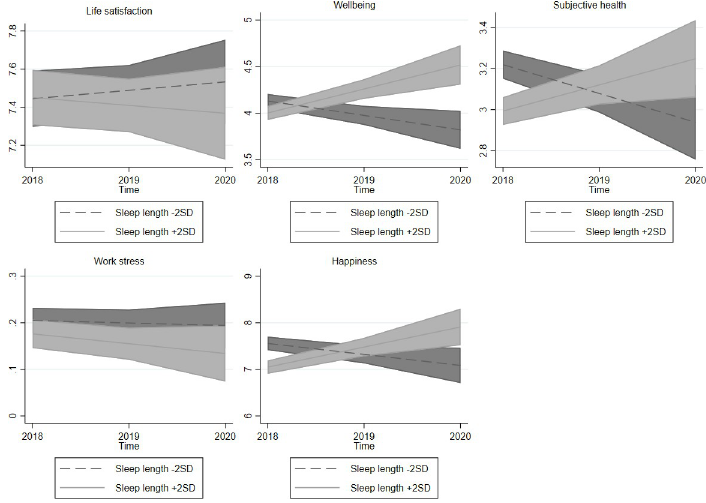
Fig 2. Sleep duration and quality of life at the individual level in time. Note: 95% confidence intervals.